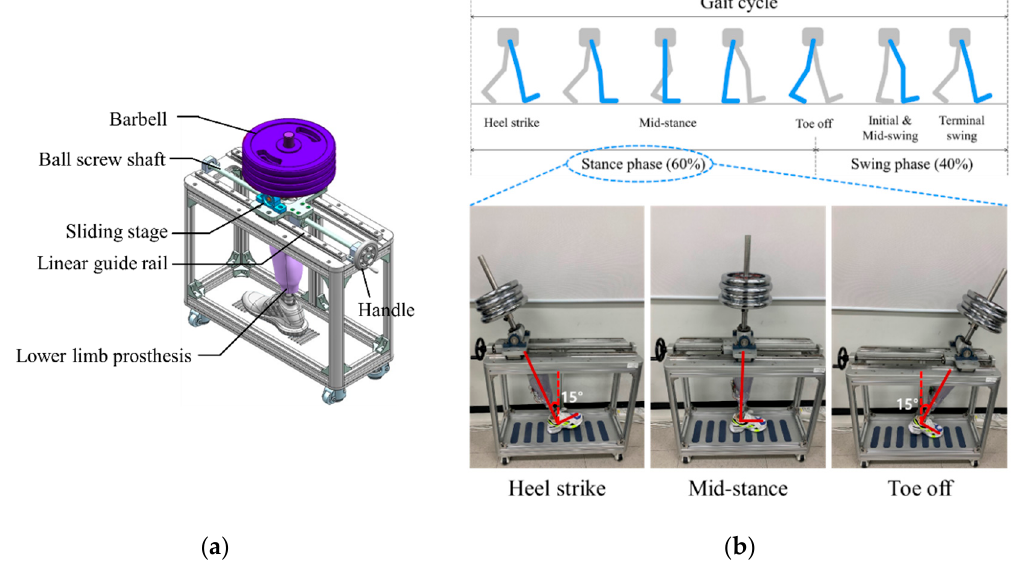
Figure 3. ( a ) The design of the gait simulator, and ( b ) the gait simulation for the stance phase of the gait cycle.